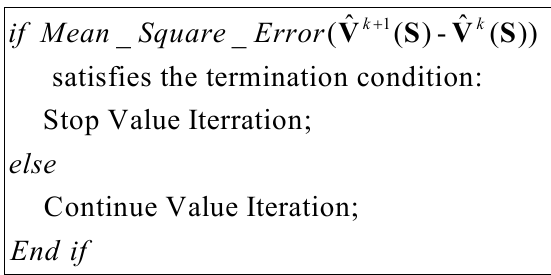
Figure 6. Pseudo code of convergence